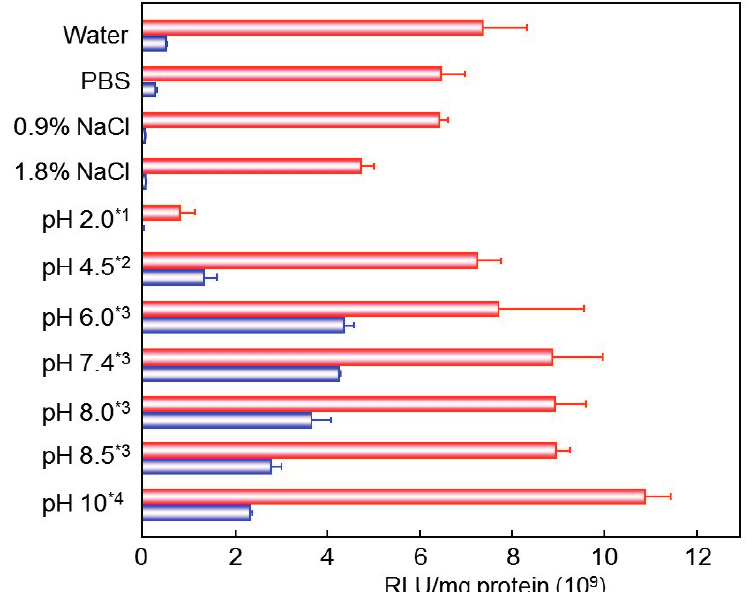
Figure 7. Gene expression profiles of the freeze-dried DNA/(PEI “Max”)/CS complexes (1:12:8) prepared in various solutions. * 1 Glycine hydrochloric acid buffer; * 2 Acetic acid buffer; * 3 Phosphoric acid buffer (PB); * 4 Glycine sodium hydroxide buffer. Red bars